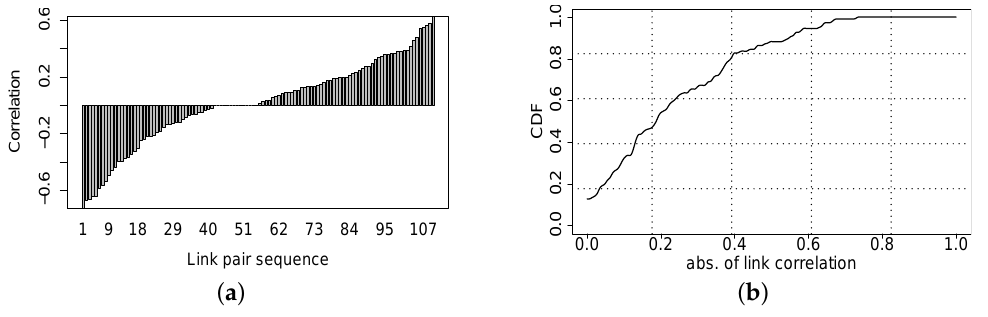
Figure 19. Correlation of all incident link pairs. ( a ) Correlation distribution; ( b ) CDF of the absolute value of correlation.